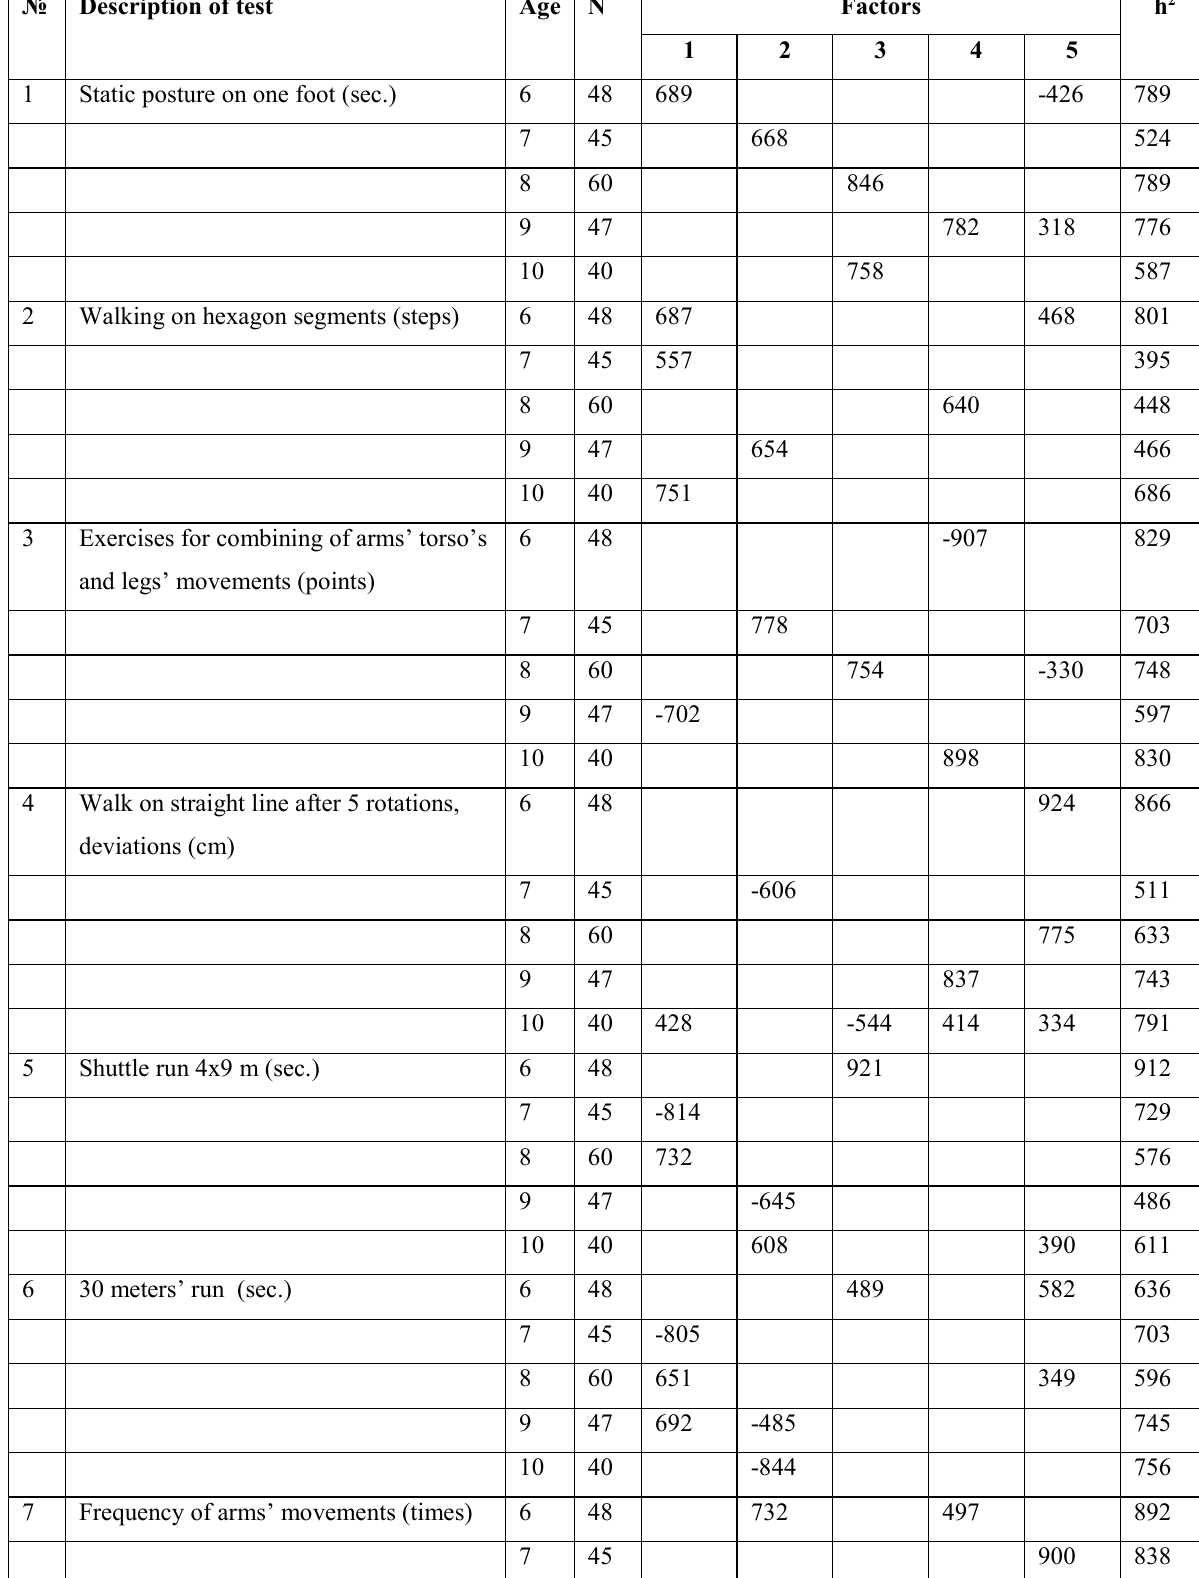
Structural model of in-group dynamic of 6-10 years old boys’ motor fitness. Method of rotation. Varimax